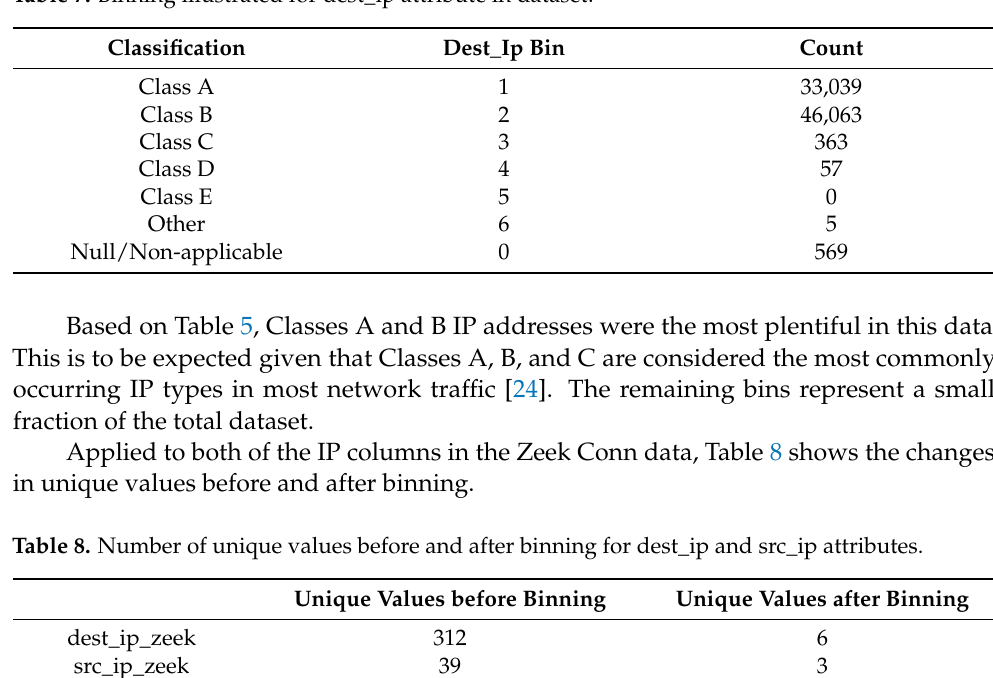
Table 7. Binning illustrated for dest_ip attribute in dataset.